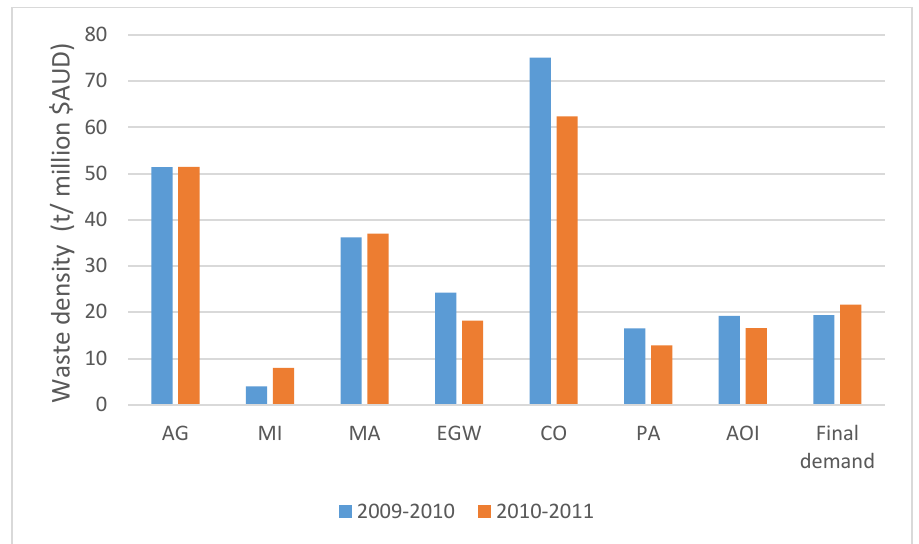
Figure 9. The waste generation intensity in intermediate sectors and the households in 2009–2010 and 2010−2011, within the Australian economy. Agriculture, forestry, and fishing = AG; Mining = MI; Manufacturing = MA; Electricity, gas, and water = EGW; Waste management services = WMS;